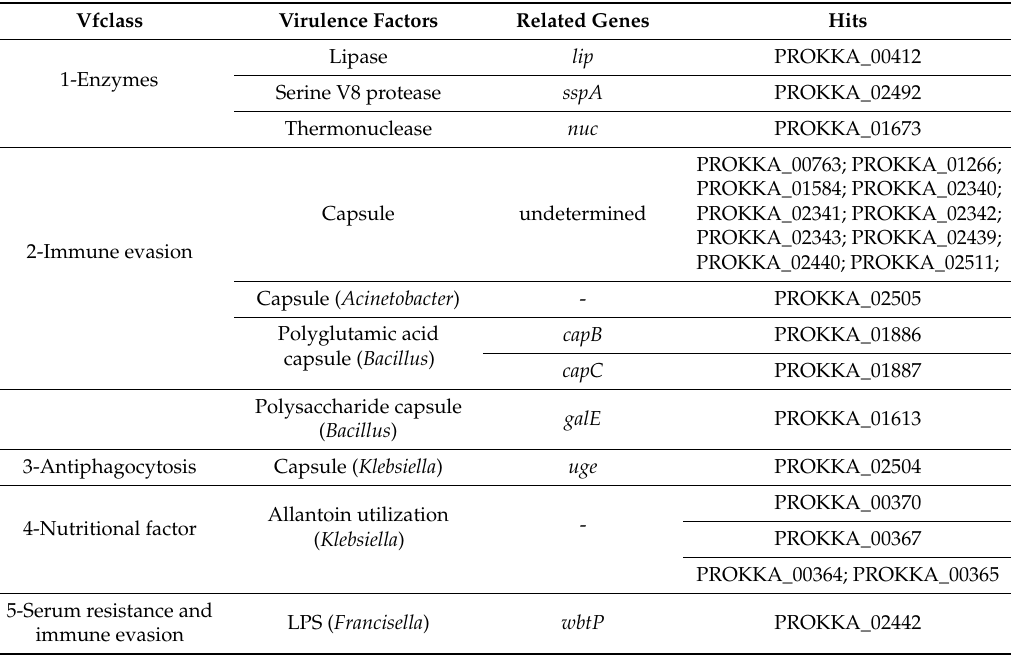
Table 3. Virulence factors encoded by SAR Bari draft genome